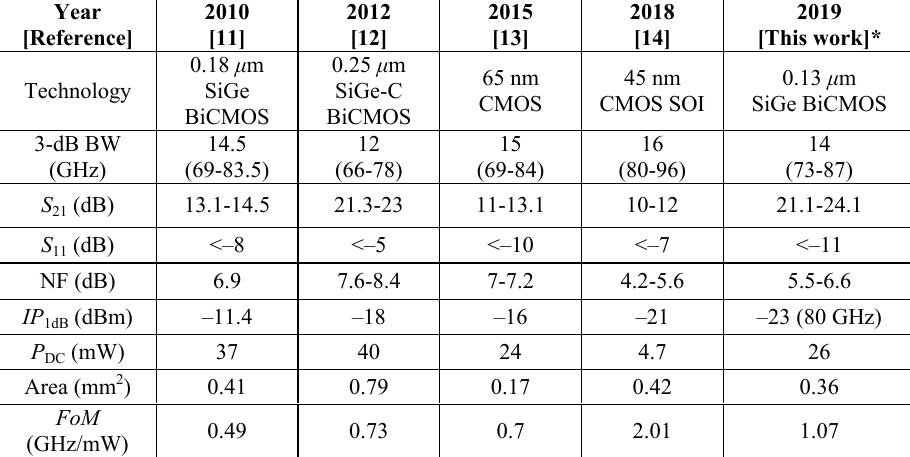
Table 2. Summary of the simulated W-band LNA and comparison to state-of-the-art mm-wave